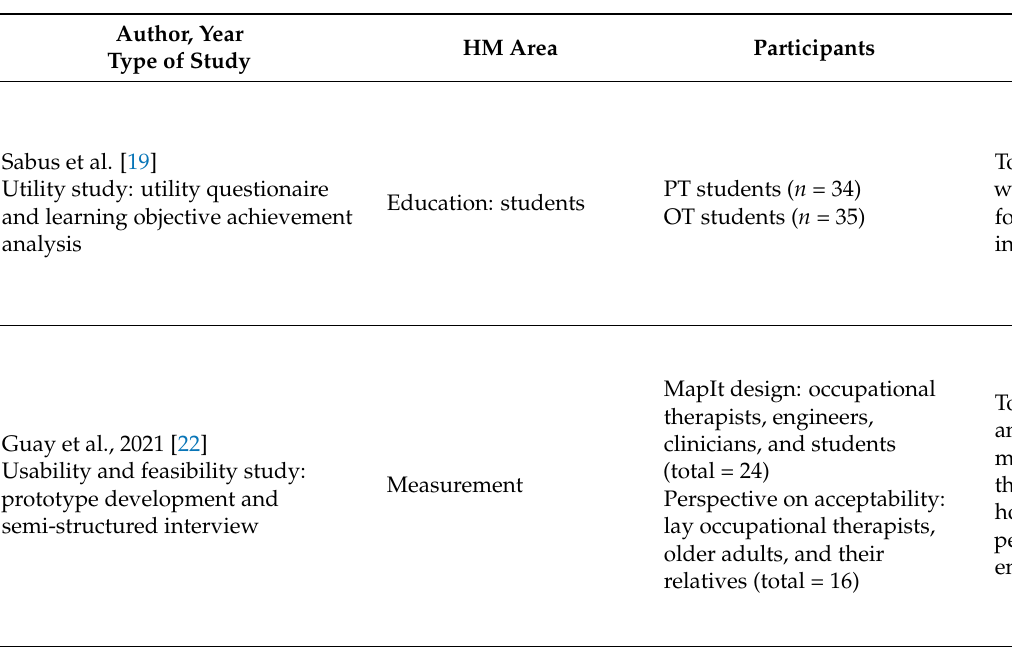
Table 1. Summary of included